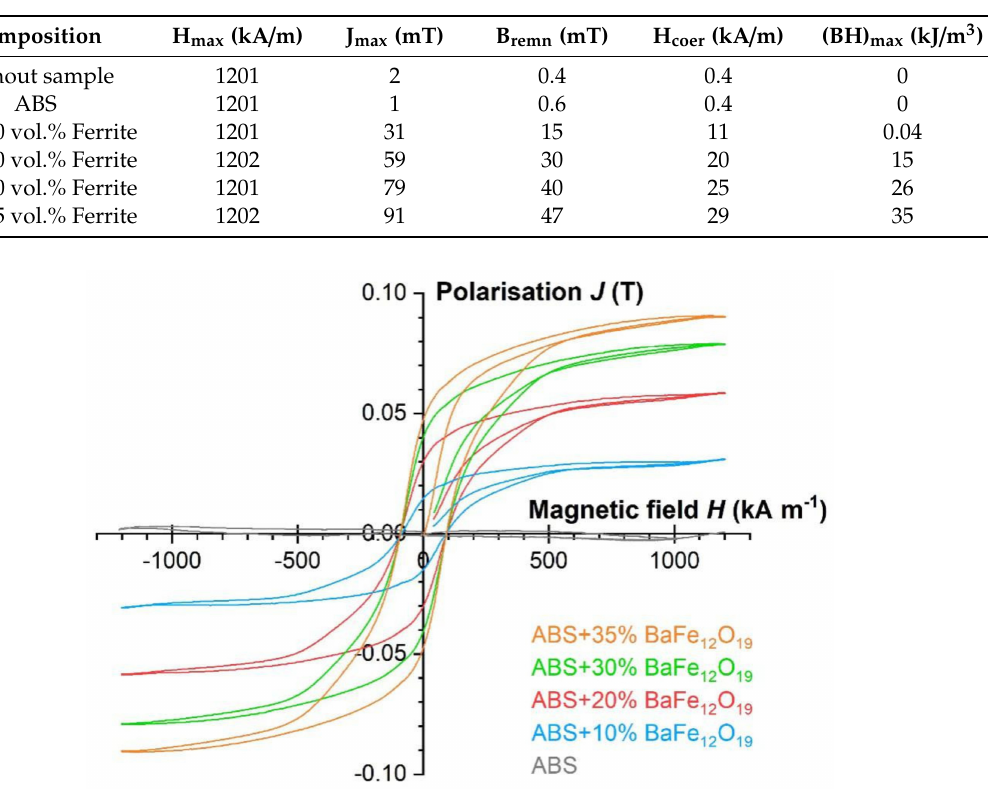
Table 3. Magnetic properties of all investigated ABS ferrite composites.